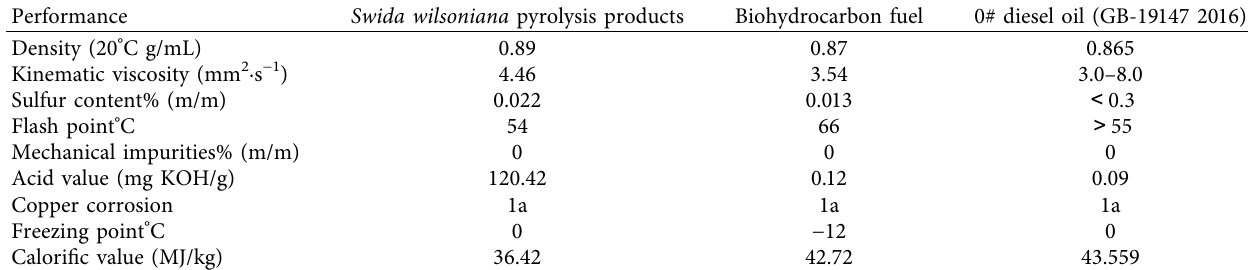
Table 7: Analysis of fuel